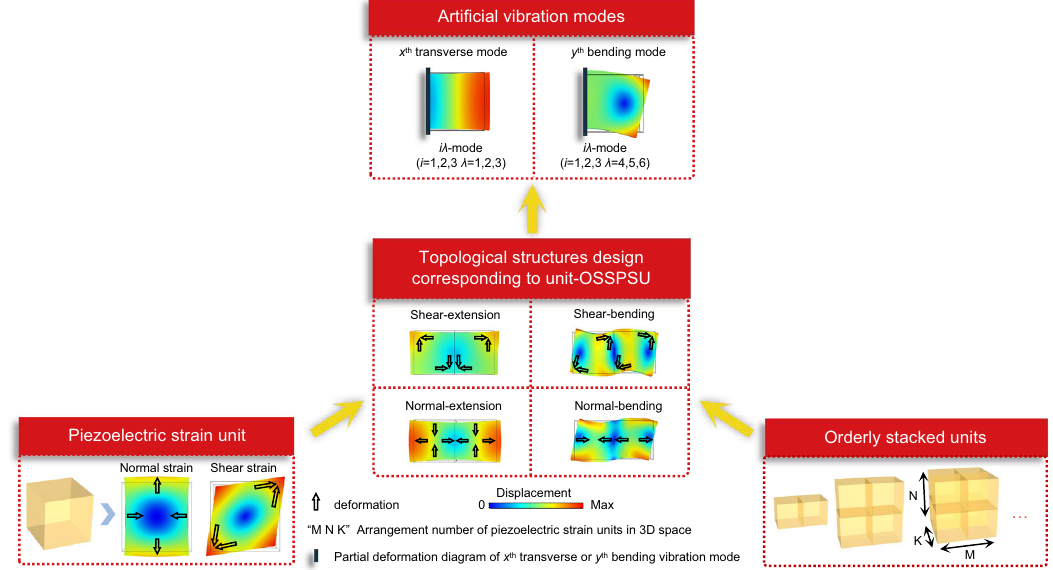
Fig. 1 | Design concept of OSSPSU methodology. The relationship among the single piezoelectric strain unit, orderly stacked units, topological structure design, and arti fi cial vibration